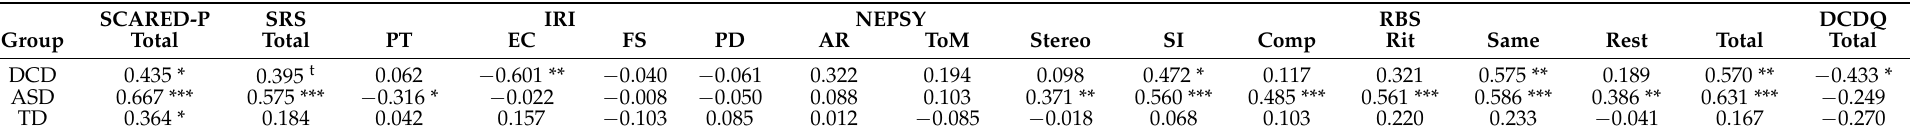
Table 2. Within-group partial correlation (r values) between sensory over-responsivity (SensOR total score) and social emotional measures, repetitive behaviors, and motor skills while controlling for age, sex, and IQ by group.